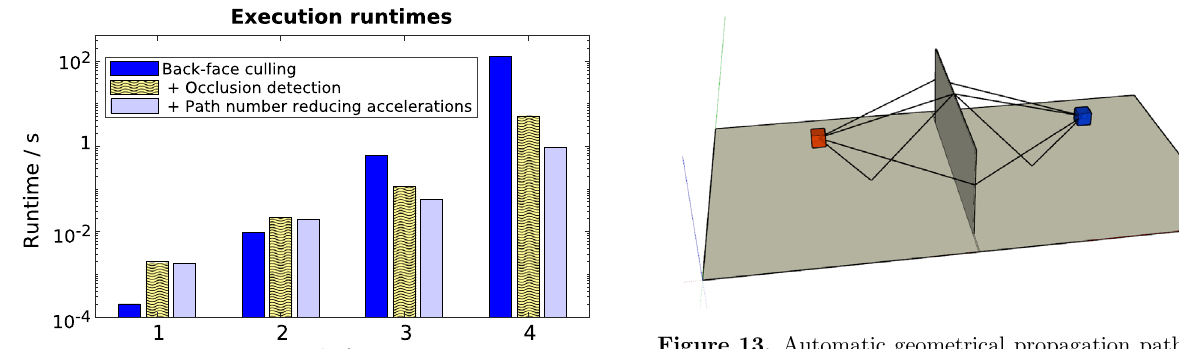
Figure 13. Automatic geometrical propagation path determi- nation based on the image edge model for BRAS scene 5 (LS01, MP01)